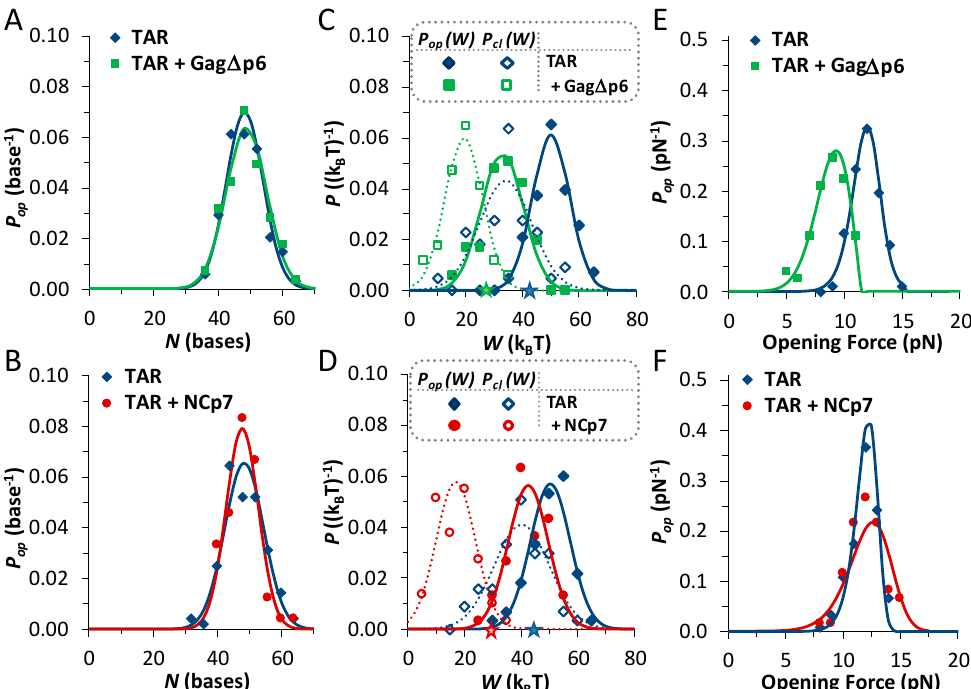
Figure 3. Force-extension / release data quantifies the energy and the barrier of unfolding. ( A ) The measured unfolding length ( ∆ x op ) for the TAR hairpin (blue, n = 86 events) and for TAR in the presence of 10 nM Gag ∆ p6 (green, n = 72). ( B ) The length for TAR alone (blue, n = 120) and in the presence of 50 nM NCp7 (red, n = 60), with no measurable change for either protein from the native hairpin. ( C , D ) The probability distributions of the work of unfolding / folding (solid / open symbols) cross at the energy of the hairpin unfolding ( ∆ G o , marked with stars placed along the axis). Both ( C ) Gag ∆ p6 and ( D ) NCp7 destabilize the TAR hairpin. ( E , F ) Distributions of the opening forces fit to the transition state model described in the text (solid lines) determining the distance to the opening barrier ( ∆ x † op ) and the barrier height ( ∆ G † op ). Data in panels ( B , D , F ) were measured under the same conditions (as part of a larger data set) as in a previous work [23]. Quantified results are summarized in Table 1. Table1. SummaryofexperimentalOT resultsand modeledmfolddataforTARunfoldingandTARinthe presence of Gag ∆ p6. Data is compared to previous results for TAR in the presence of NCp7. The opening length ( ∆ x op ) and energy ( ∆ G op ) are calculated from OT and mfold data and are independent of force. The distance to the barrier ( ∆ x † op ) and the height ( ∆ G † op ) are measured in OT experiments and calculated in mfold at the force F 1 , where the probability of observing unfolding / folding is equal ( P op = P cl ). 2 The natural rate of opening ( k 0 op ) in the absence of force was also found from OT data and reflects the instability of the TAR hairpin in the presence of NCp7 relative to the TAR and TAR + Gag ∆ p6. ∆ x Experiment